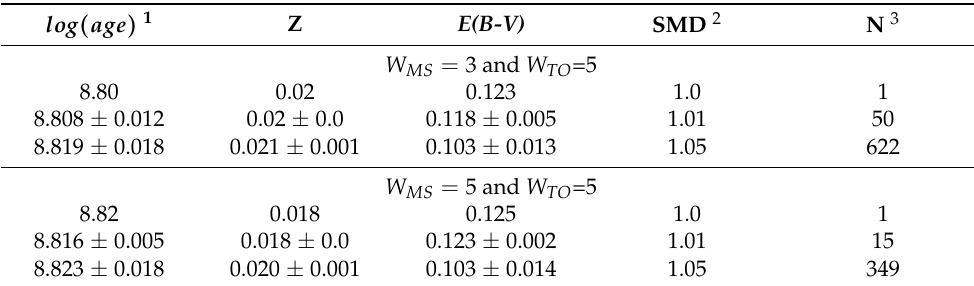
Figure 7. Best isochrone fit for the W MS = 5 and W TO = 5 weights case. Table 4. Best isochrone